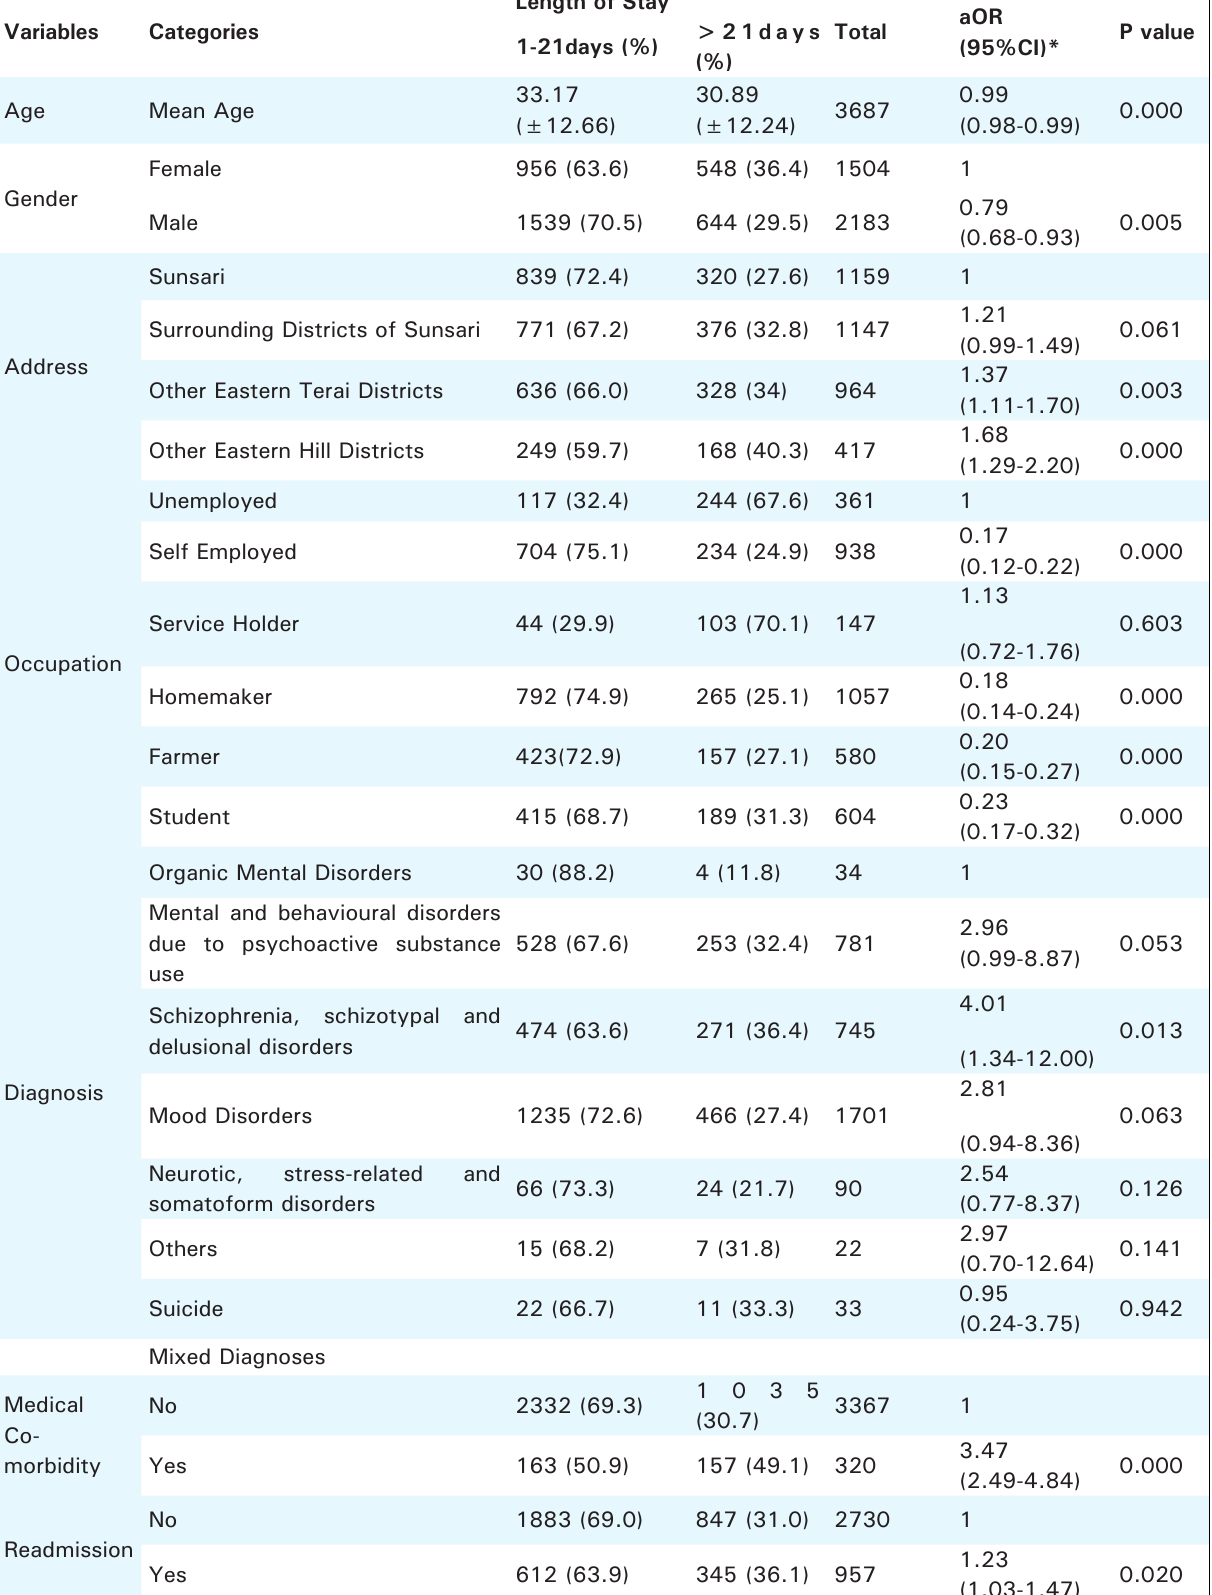
Table 1. Multivariable logistic regression for factors associated with long hospital stay (>21days) among psychiatric admissions in B. P. Koirala Institute of Health